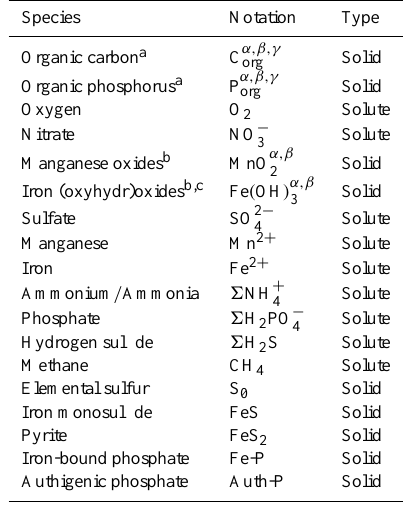
Table 3. Chemical species included in the model, after Reed et al. (2011b).